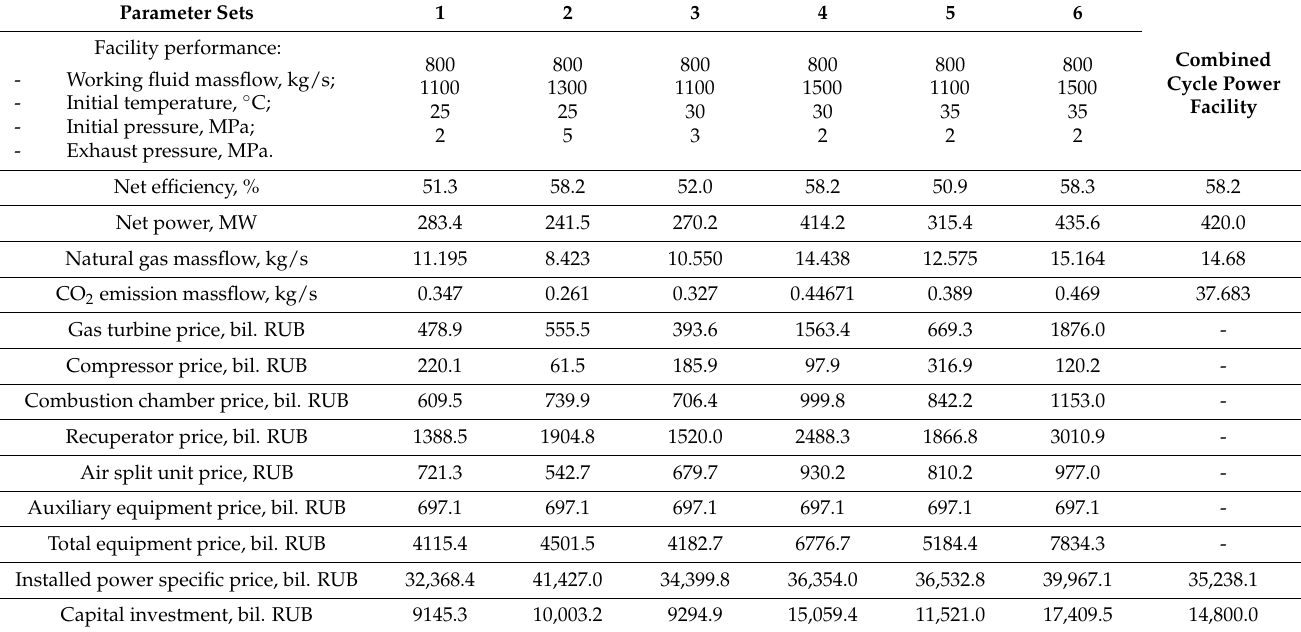
Table 3. Technical and financial performances of oxy-fuel power facilities against those of combined cycle facilities.